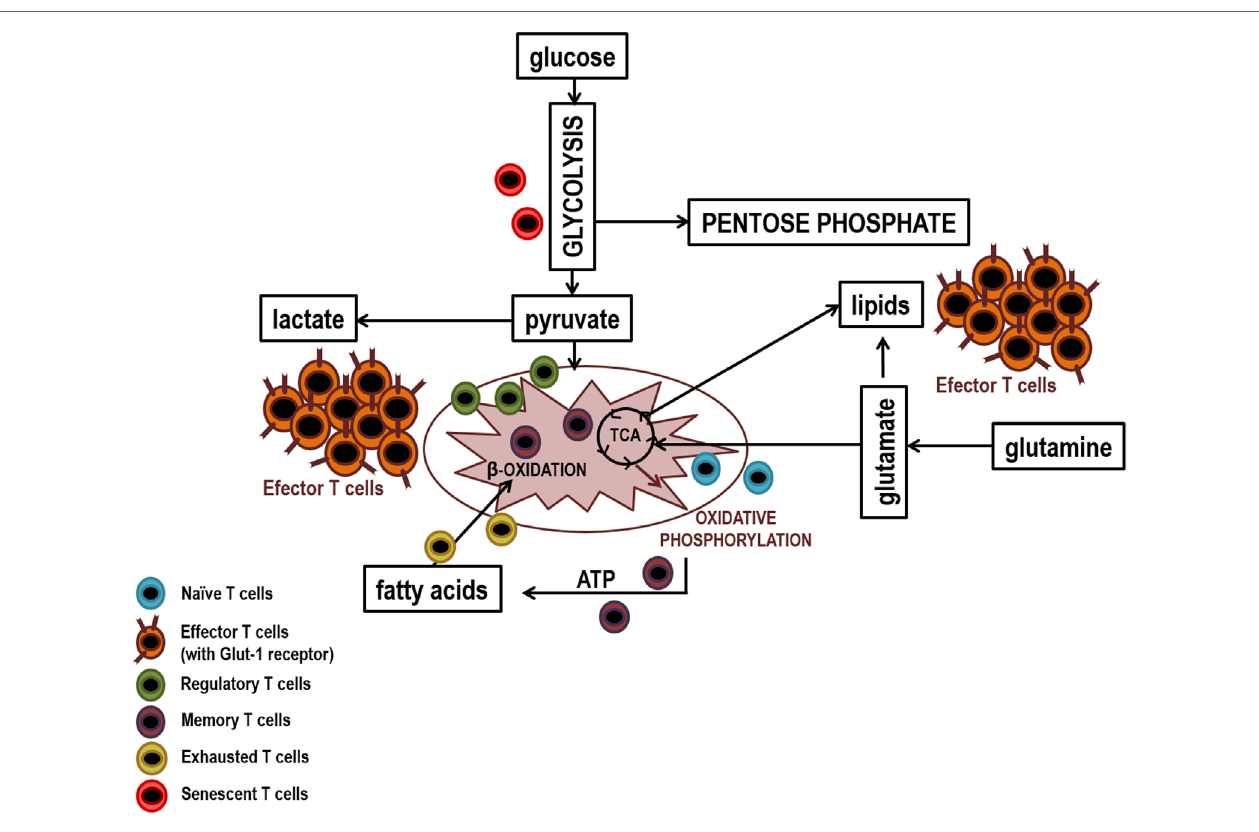
FiGURe 4 | Main metabolic pathways of lymphocyte subpopulations. Naïve, memory, and regulatory T lymphocytes uptake low levels of glucose which it is metabolized by glycolysis and then the pyruvate generated is fully oxidized to CO 2 in the mitochondria by the Krebs cycle. In contrast, effector lymphocytes have a large demand for glucose to maintain the biosynthetic processes that facilitate cellular growth, proliferation, and the synthesis of substantial quantities of effector molecules. Thus, effector lymphocytes show higher production of glucose transporters (GLUTs) and higher activity of glycolytic enzymes that facilitates elevated rates of glucose uptake and glycolytic flux. To sustain high rates of proliferation, pyruvate is converted to lactate and released out of cells. This prevents the accumulation of pyruvate which could result in the inhibition of the glycolysis pthway. Due to the high levels of glycolytic flux, glycolytic intermediates can be diverted into biosynthetic pathways to generate amino acids, lipids, and nucleotides in order to generate biomass. Senescent T lymphocytes use glycolysis extensively, partly because they have dysfunctional mitochondria and exhausted T lymphocytes mainly use lipid metabolism to carry out their poor cellular